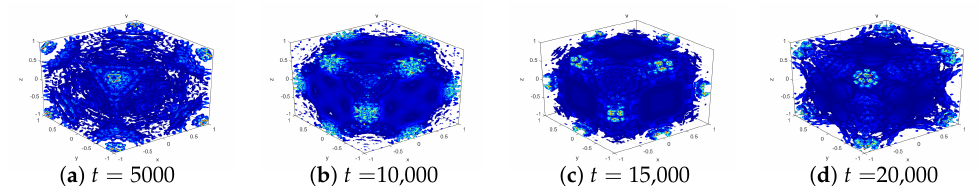
Figure 17. The patterns of v at K u = 2 × 10 − 5 , K v = 1 × 10 − 5 , F = 0.015, k = 0.045, and α = β = 1.9 for Experiment 3.